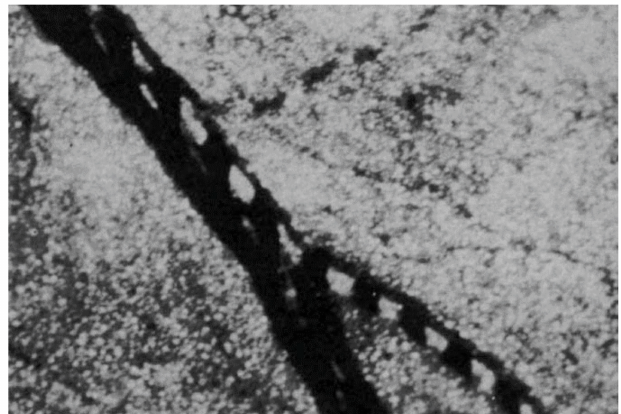
Figure 1. Red blood cell manipulation by ultrasound in a chick embryo. The image shows a chick embryo vasculosa where red blood cells are trapped in clusters separated by half the wavelength at 3 MHz continuous ultrasonic irradiation. The image was acquired through a microscope with 26 × magnification. Reprinted with permission from